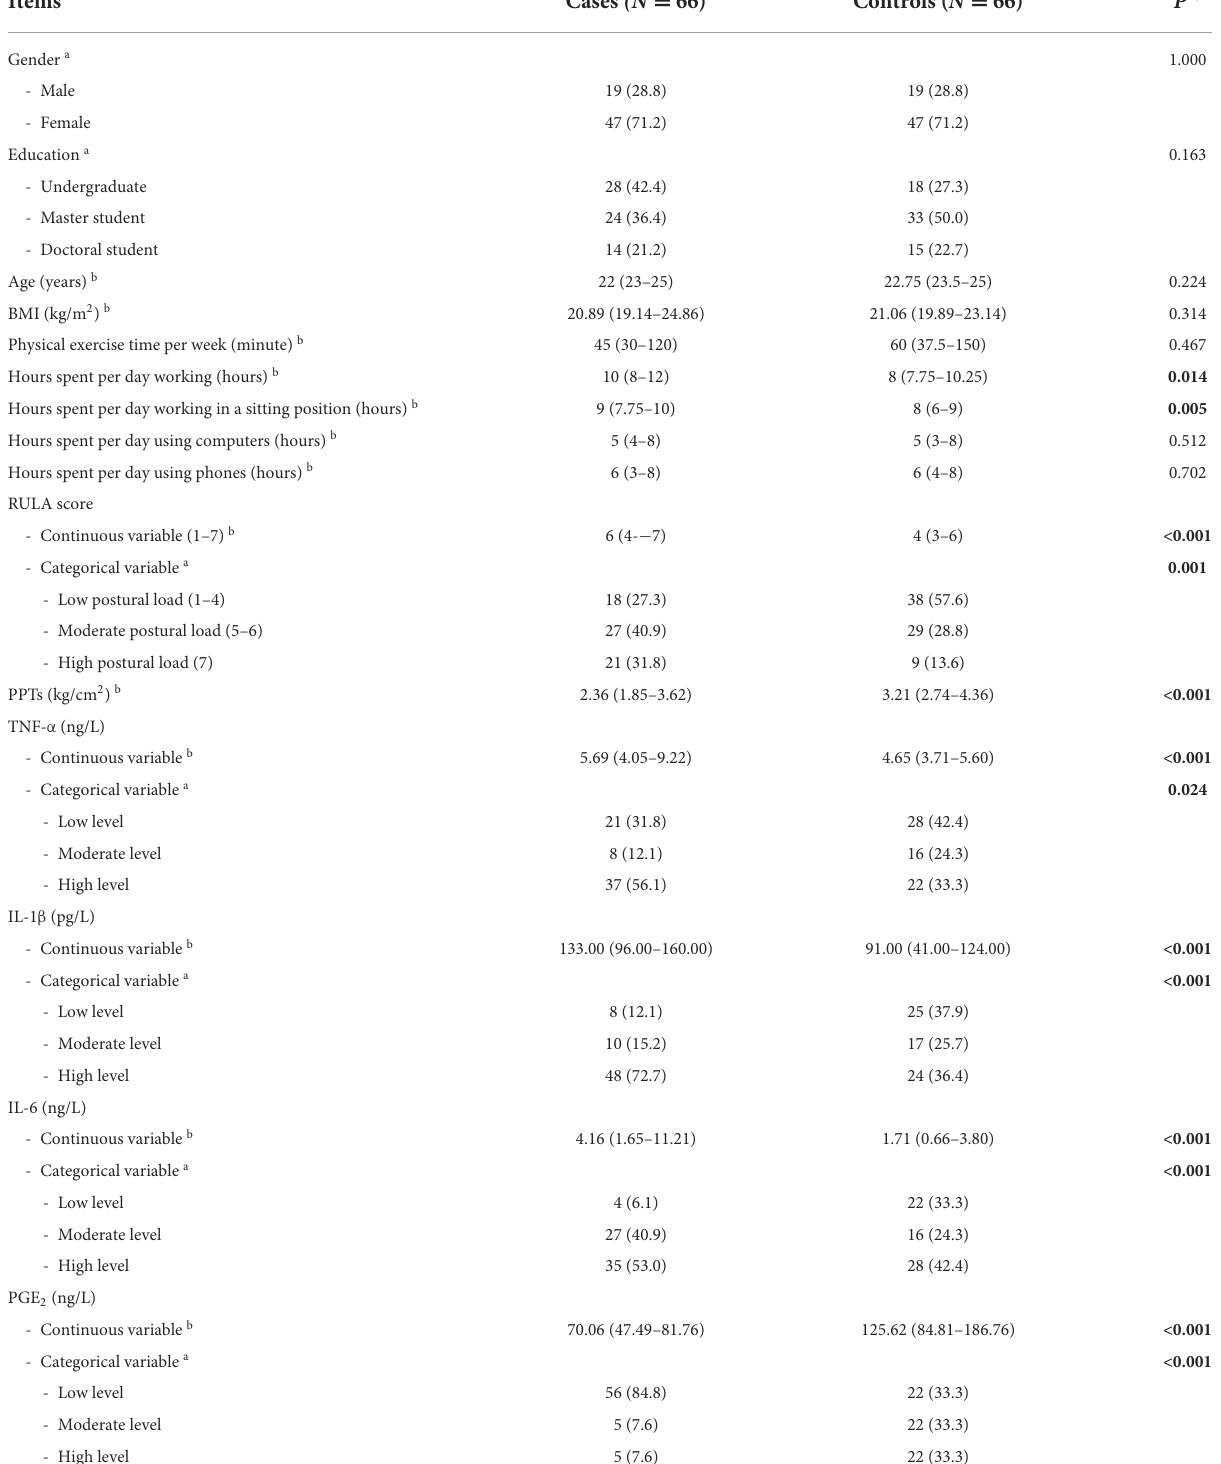
TABLE 1 Demographic, occupational, and clinical characteristics of lower back MSDs cases and controls ( N =